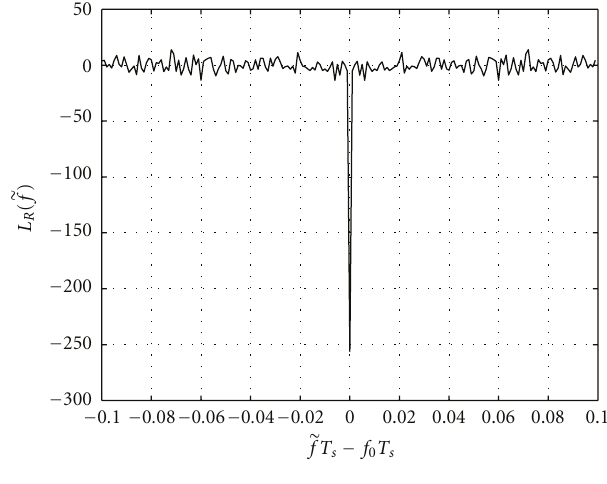
Figure 4: L R ( (cid:2) f ) versus the frequency o ff set estimation error ( (cid:2) f T s − f T s 0